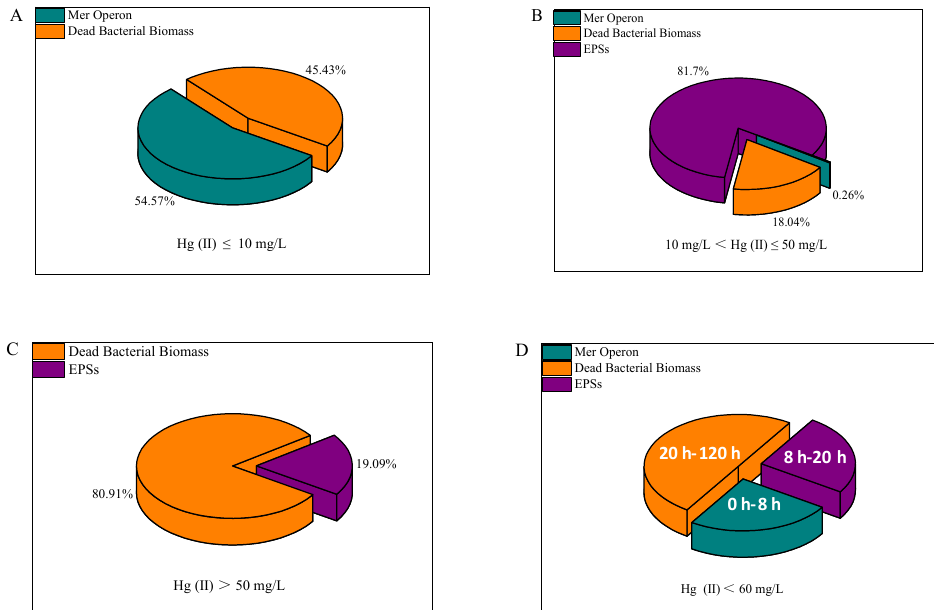
Figure 5. Overall removal mechanisms of Hg(II) by the RTS-4 bacteria, including the removal mechanisms when ( A ) Hg(II) ≤ 10 mg/L, ( B ) 10 mg/L ≤ Hg(II) ≤ 50 mg/L, and ( C ) Hg(II) > 50 mg/L. ( D ) Principal removal mechanism at different times. “Dead bacterial biomass” represents the adsorption of Hg(II) by dead bacterial biomass; “Mer operon” represents the reduction of Hg(II) by mer operon, and “EPSs” represents the adsorption of Hg(II) by producing extra-cellular polymeric substances (EPSs).